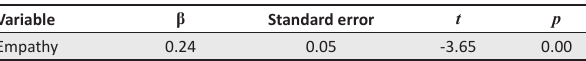
TABLE 6: Stepwise multiple-regression